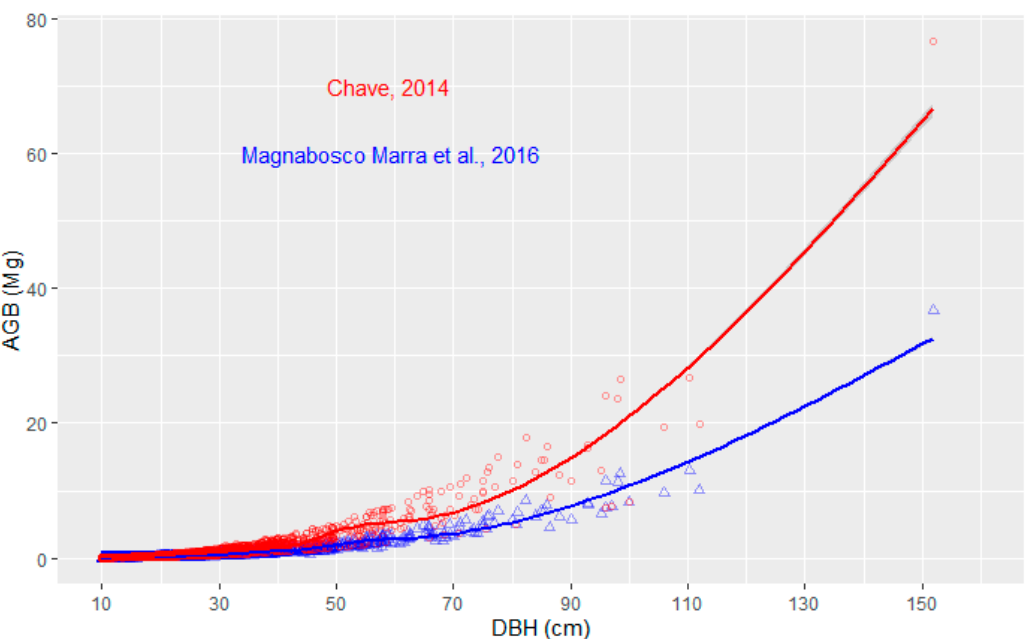
Figure A1. AGB estimations for model 1 (Chave et al, 2014) and model 2 (Magnabosco Marra et al., 2016) at circles and triangles, respectively. Red and Blue lines show the regression using Generalized additive model (GAM) for both models.